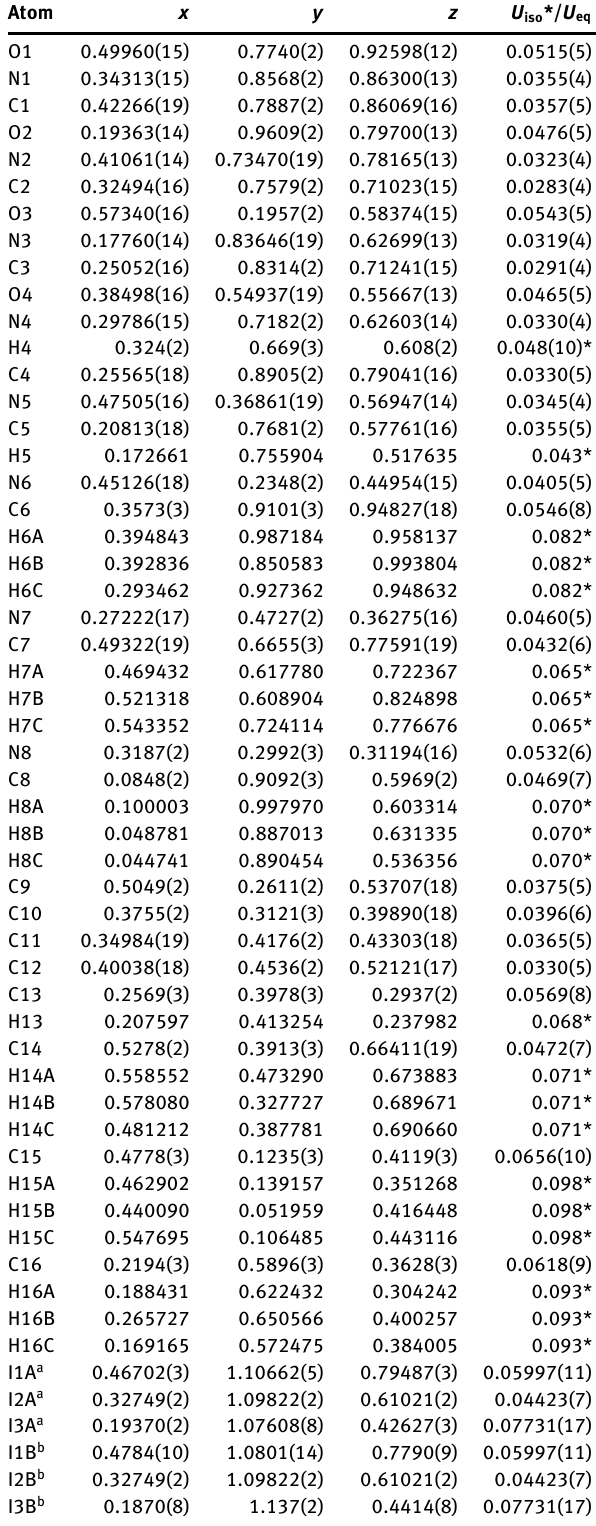
Table 2: Fractional atomic coordinates and isotropic or equivalent isotropic displacement parameters (Å 2